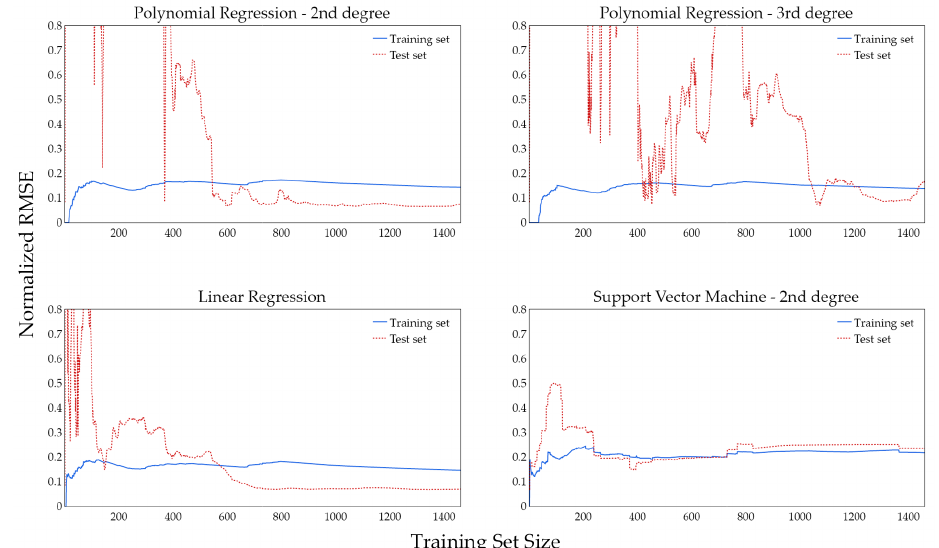
Figure 11. Learning curves of proposed models for 2nd DCT frequency component (latitude: 22.5 ◦ S, longitude: 180 ◦